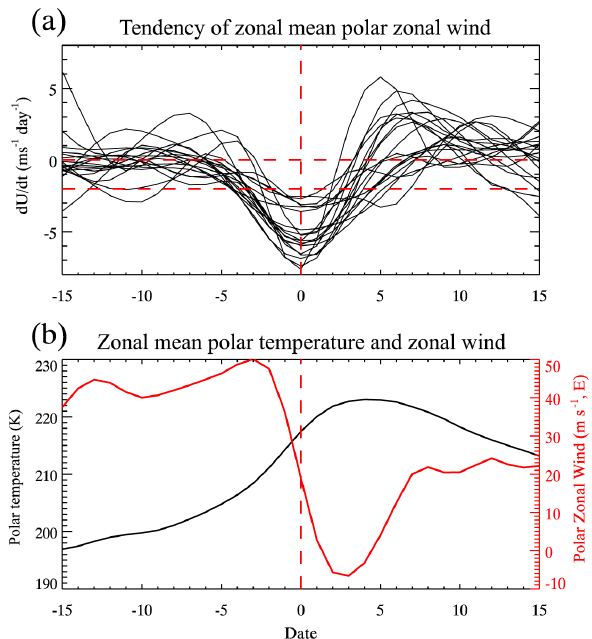
Figure 1. Time series of (a) the tendency of zonal mean zonal wind of each identified SSW event, and (b) the zonal mean polar temper- ature (black) and zonal wind (red, positive eastward) averaged by all the identified SSW events, at 10hPa averaged between 60 and 90 ◦ N. The vertical dashed line indicates the central date (day 0) when the decreasing rate of zonal winds for each SSW event is the largest. The horizontal dashed lines in (a) correspond to 0 and − 2ms − 1 day − 1